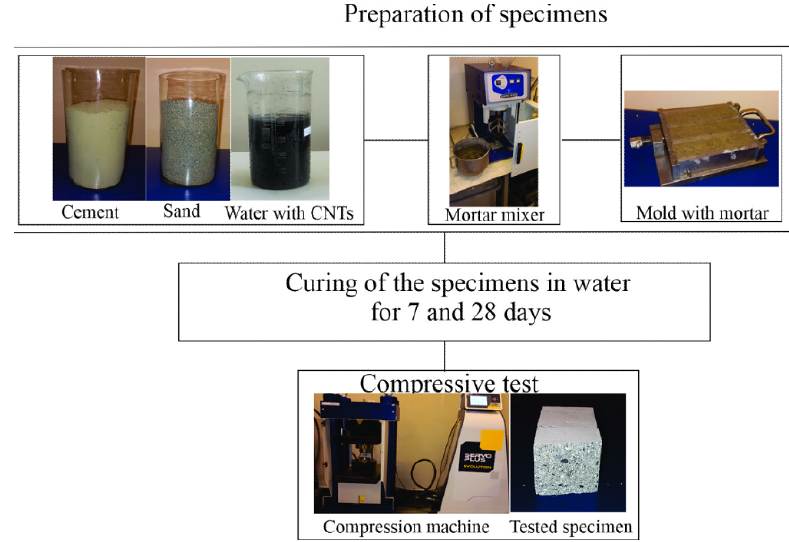
Figure 2. Diagram of the experimental procedure.